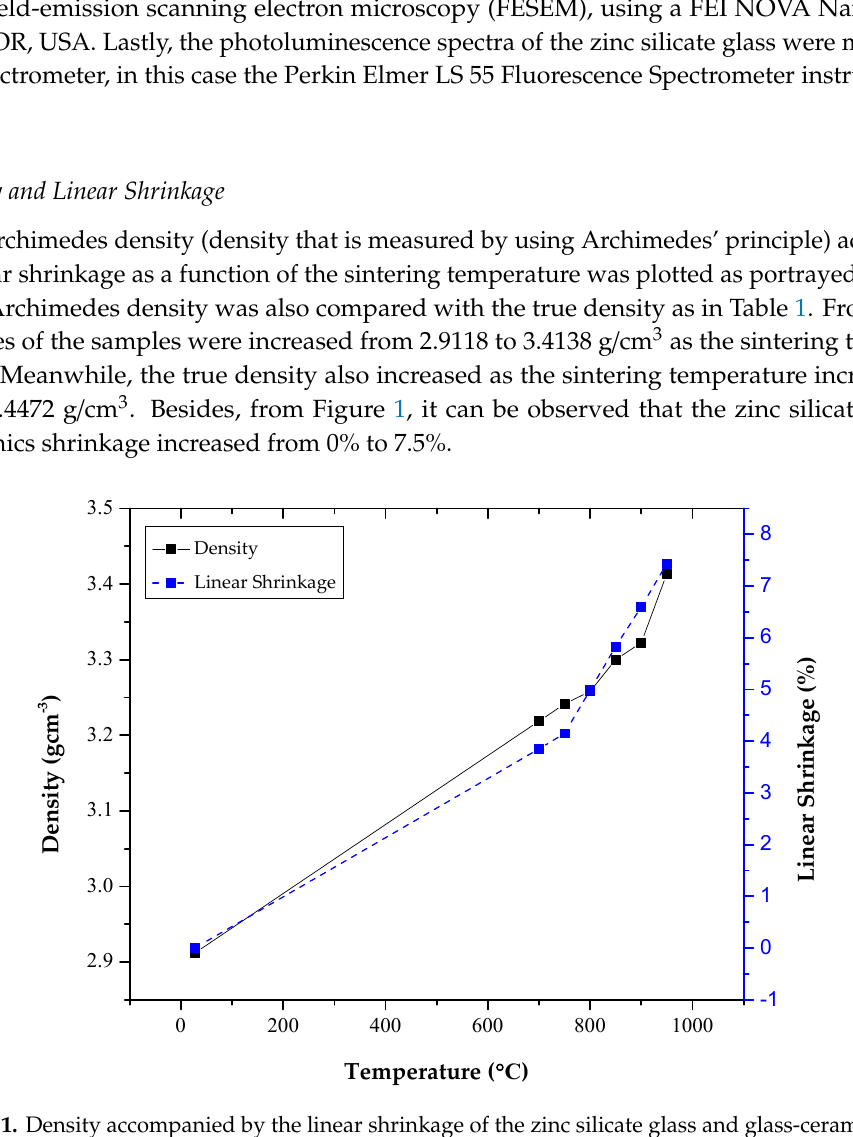
Figure 1. Density accompanied by the linear shrinkage of the zinc silicate glass and glass-ceramics that were heat treated at various sintering temperatures. Table 1. Comparison of the values measured from the Archimedes density and true density.